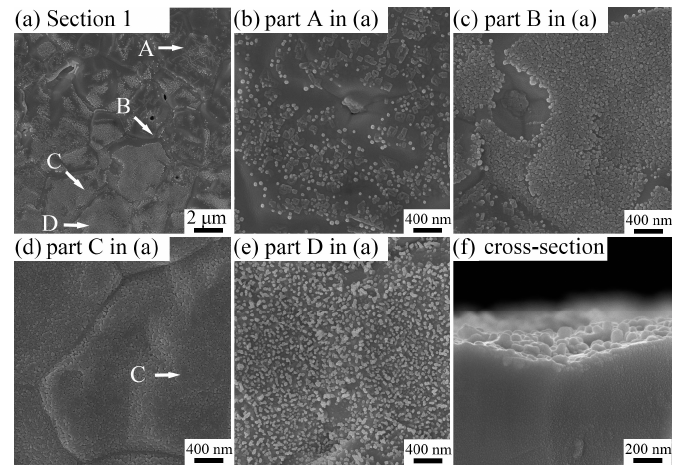
Figure 1. Scanning electron microscopy (SEM) micrographs of La 0.6 Sr 0.4 Co 0.2 Fe 0.8 O 3 −δ (LSCF) sample